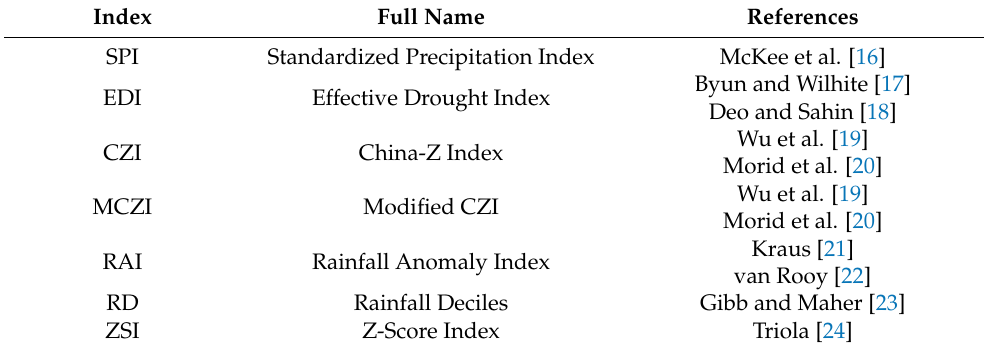
Table 2. Meteorological drought indices used in this study.